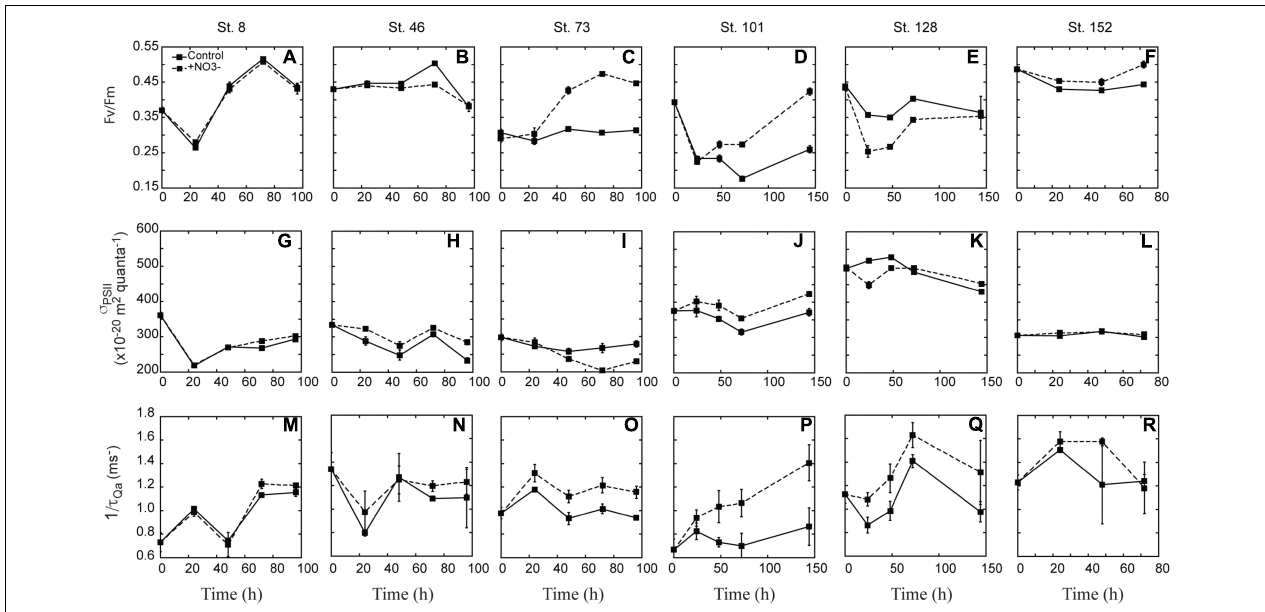
FIGURE 6 | Response of FRRf parameters [ F v : F m (A–F) , σ PSII (G–L) , 1/ τ QA (M–R) ] to the addition of NO 3 − . Shown are averages ( ± SD) at each time point sampled.